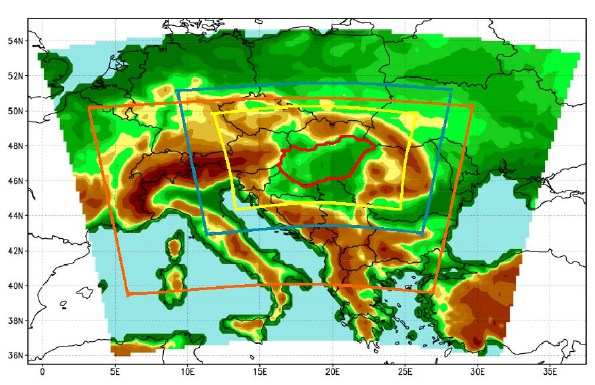
Fig. 1. Model integration domains: yellow, blue and orange curves represent the domains covered by ALADIN-Climate, RegCM and PRECIS, respectively; the largest domain and its orography belongs to REMO.